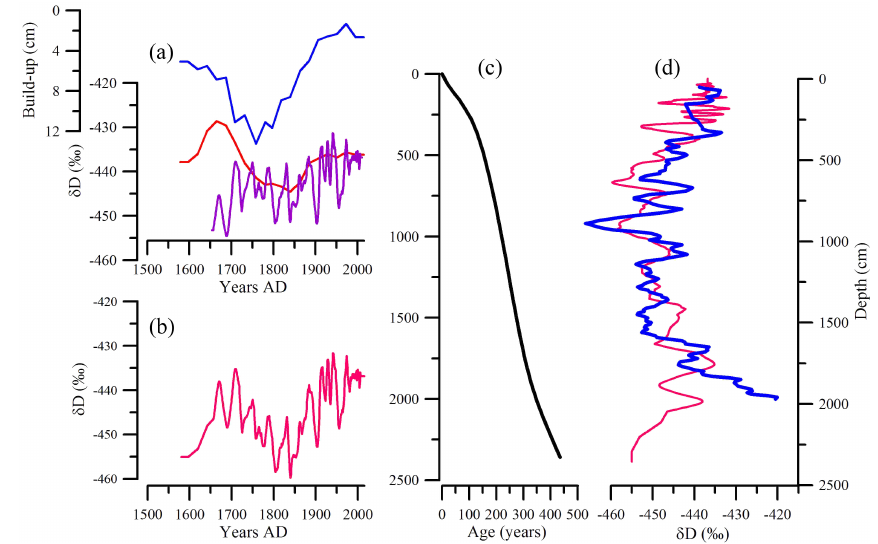
Figure 5. Simulated isotope profile in MD00 point. (a) The values of snow accumulation rate (blue) and isotopic composition (red) that could be observed in point MD00 if one measured them for as long as the dune travel across this point. To calculate this we used the data from Fig. 3a and e and data on the dune drift velocity. Purple shows climatic variability of the snow isotopic composition in the Vostok region taken from (Ekaykin et al., 2014). (b) A combination of climatic and dune-related isotopic variability (red and purple from Fig. (a) ). (c) Depth–age function for the snow thickness in point MD00. (d) Simulated vertical profile of snow isotopic composition calculated using the data from (b) and depth–age function (c) , in red, compared with the real vertical profile of snow isotopic composition measured in the core drilled in point MD00, in